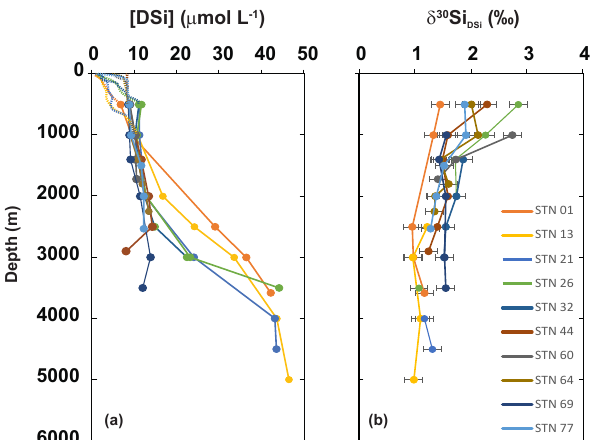
Figure 2. Depth profiles of (a) Si concentration and (b) δ 30 Si DSi values for the North Atlantic Ocean and Labrador Sea. Nutrient data collected during the GEOVIDE cruise from a separate cast are indi- cated as dashed lines (see Table